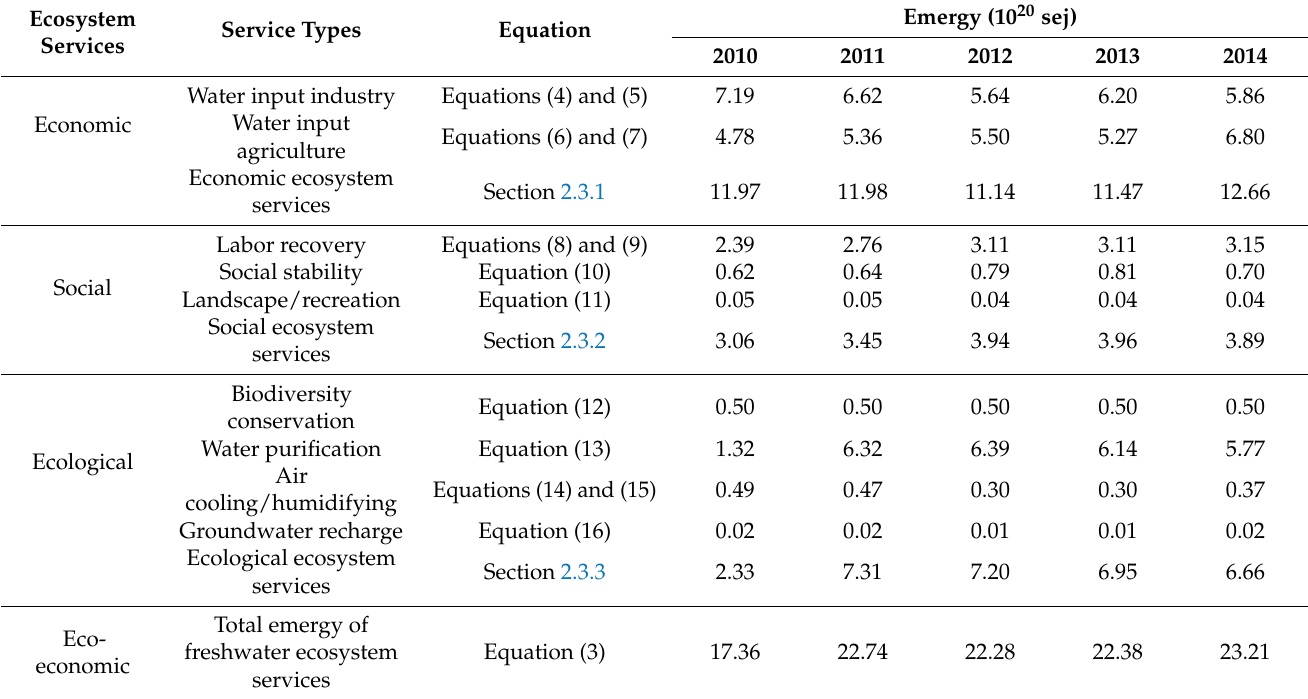
Table 1. Emergy of freshwater ecosystem services in Qingyi River Basin of Xuchang from 2010 to 2014.